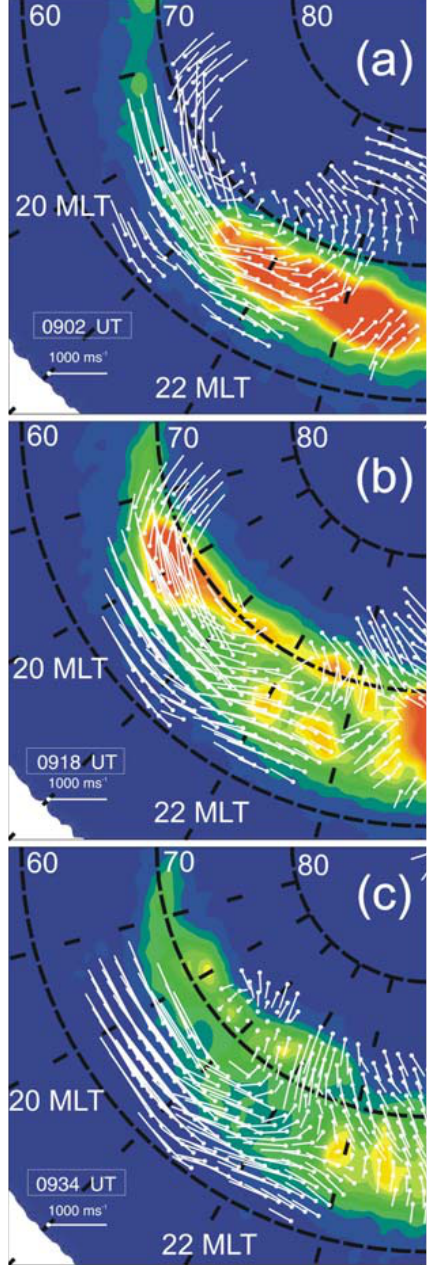
Fig. 8. Auroral luminosity distribution in the dusk sector (IMAGE) and plasma convection (SuperDARN) in magnetic local time – mag- netic latitude coordinates. Red (blue) color corresponds to strongest (weakest) luminosity. (a) 09:02 UT. Fast flow is seen in the area westward of the brightest luminosity (auroral bulge) in the magnetic local time sector of 20:00–21:00 MLT. (b) 09:18 UT. Fast flow starts developing in the area equatorward of the brightest luminosity in the magnetic local time sector of 20:00–22:00 MLT. (c) 09:34 UT. Very fast flow is seen in the area equatorward of the brightest luminosity in the magnetic local time sector of 20:00–22:00 MLT.